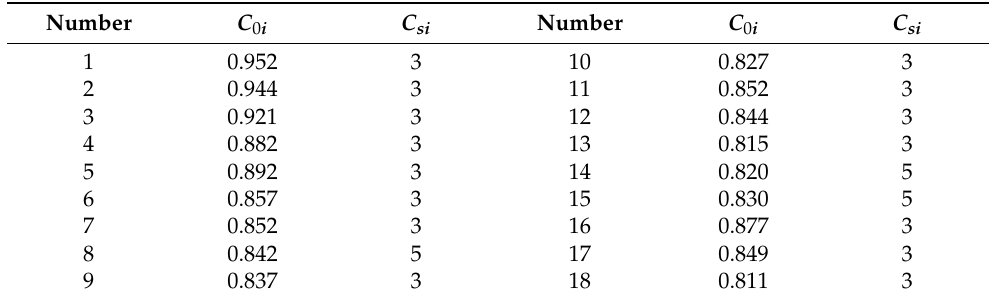
Table 5. Parameter on COD Mn (mg/L).